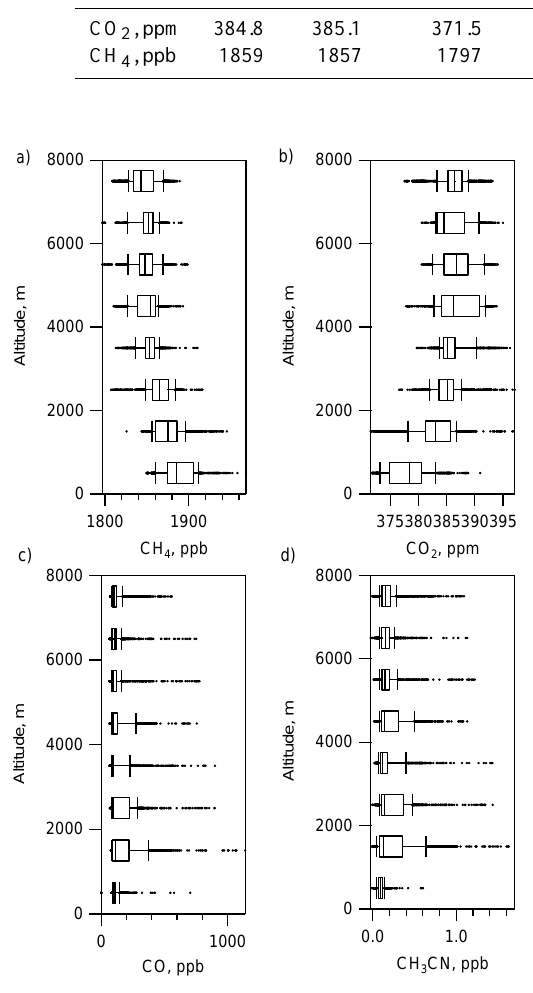
Fig. 3. The relationships between CH 4 , CO 2 , CO and CH 3 CN for the BORTAS flights with the exception of the Atlantic